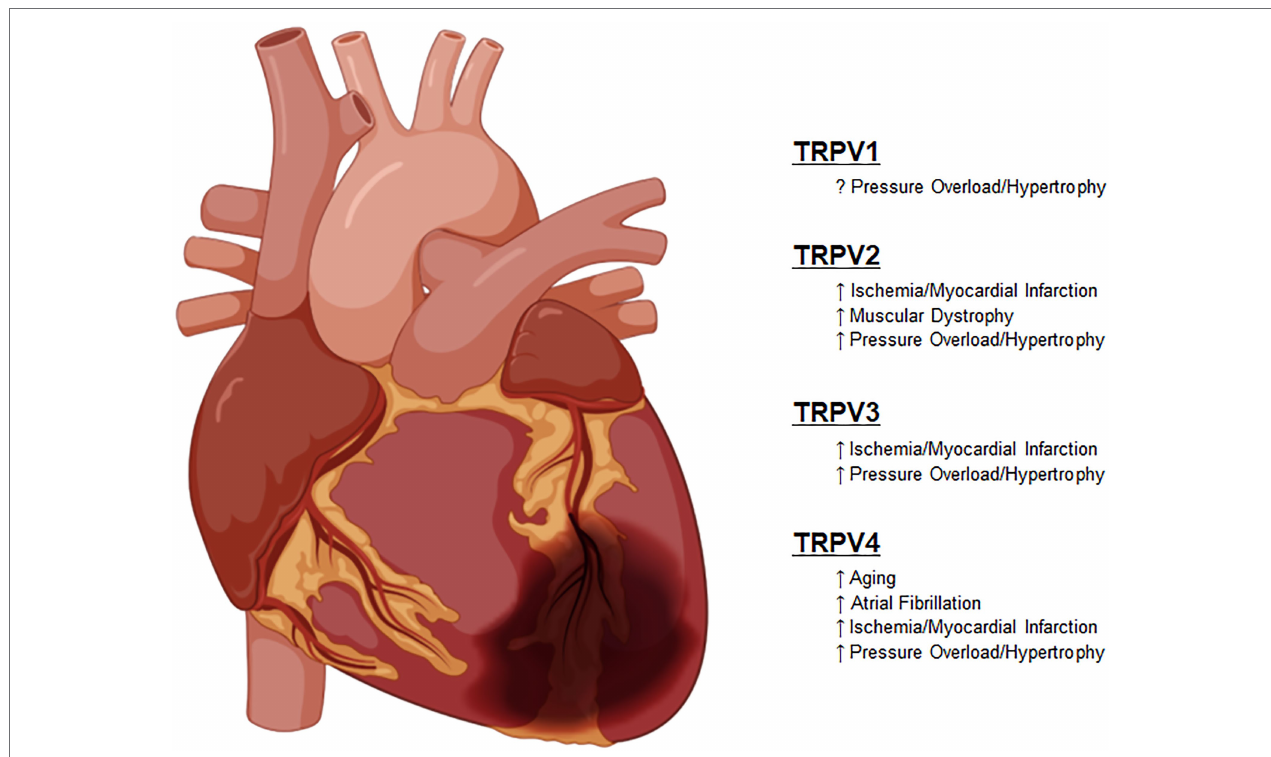
FIGURE 2 | Known roles of TRPV channel responses to pathologic